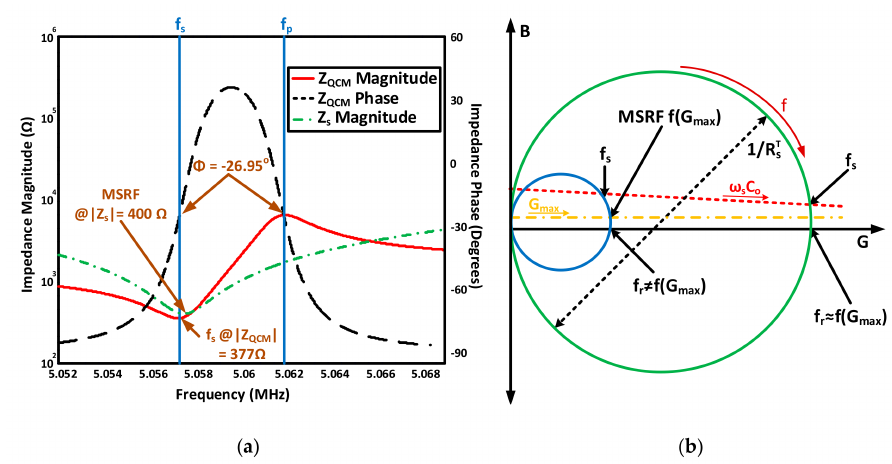
Figure 5. Effect of damping on QCM response. ( a ) Impedance magnitude and phase responses around resonance, for a liquid-loaded, typical 5 MHz QCM crystal; ( b ) QCM admittance locus under different damping